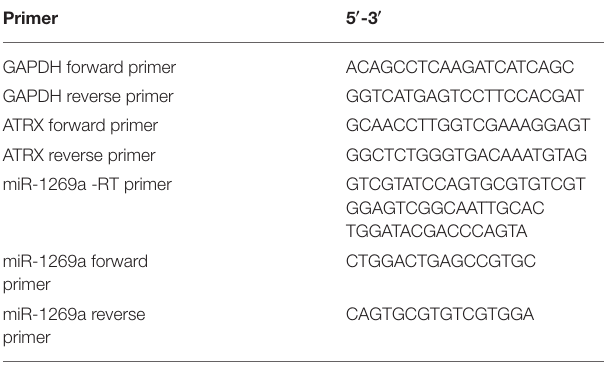
TABLE 1 | The sequences of the primers used in this